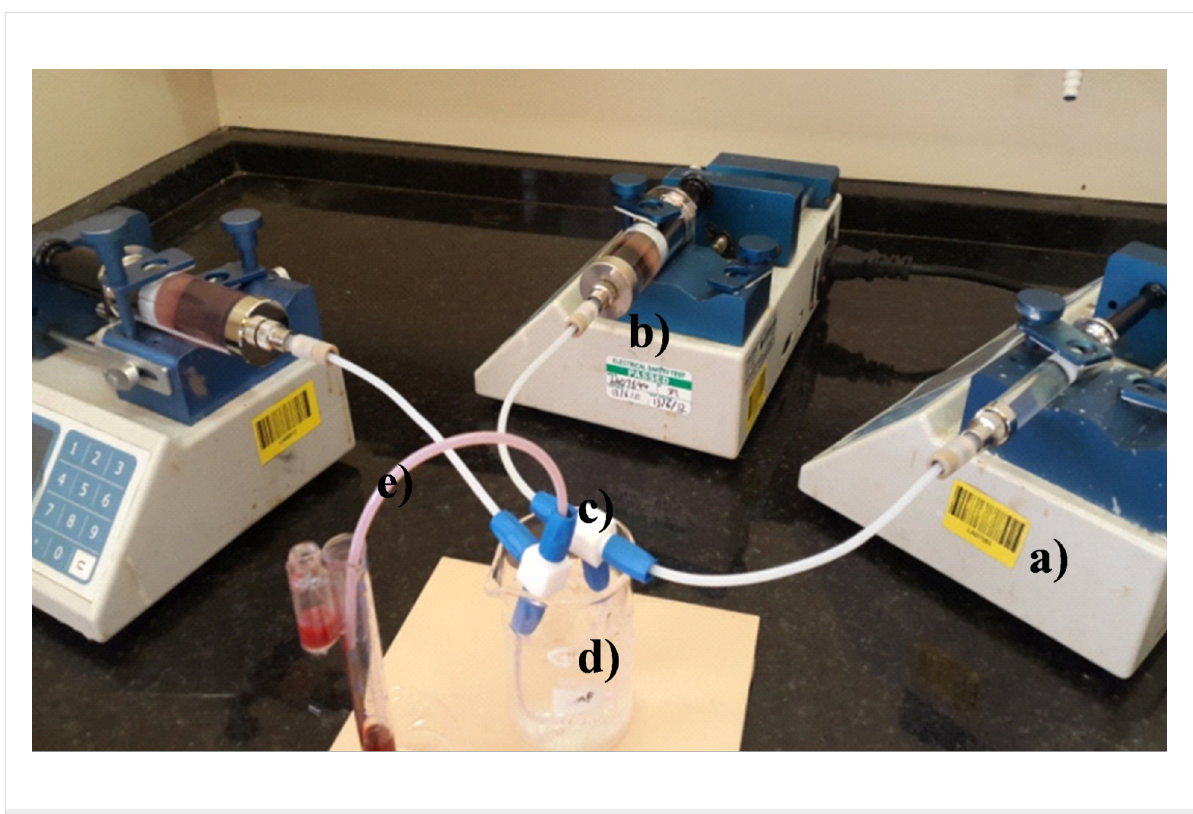
Figure 8: Scaled up microreactor set up: PTFE tubing i.d. 1.5 mm a) Chemyx Fusion 100 classic syringe pump, b) SGE glass syringe, c) T-mixer, d) Ice bath: Diazotization reaction and e) Room temperature: Azo coupling reaction.